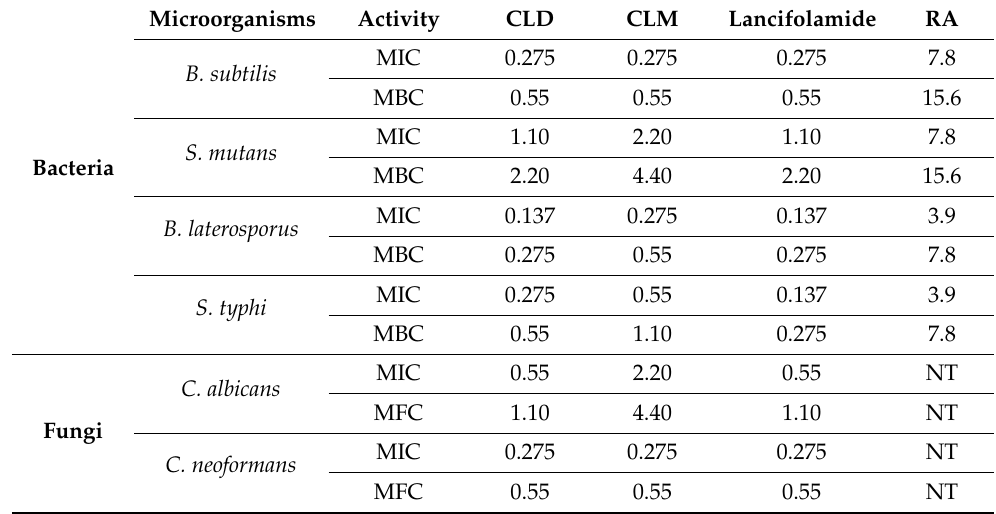
Table 8. Antimicrobial and antifungal potential of extracts and